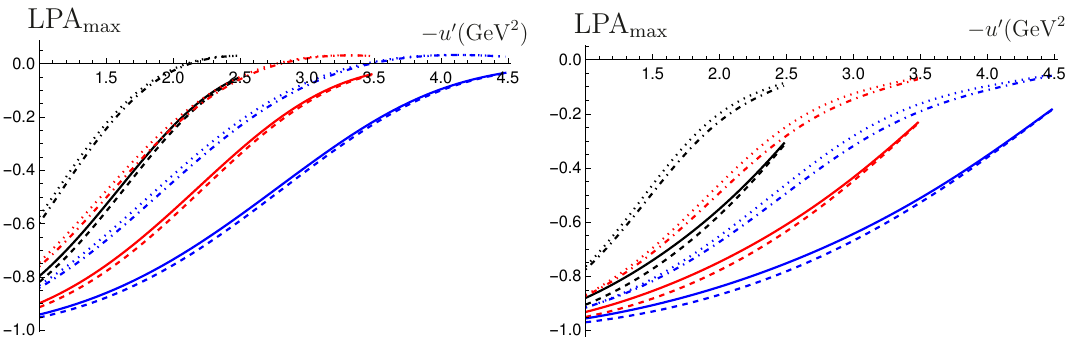
Figure 18 . The LPA at the fully-differential level for π + ( π − ) is shown as a function of ( − u 0 ) on the left (right) for different values of M 2 . The black, red and blue curves correspond to γπ = 3 , 4 , 5 GeV 2 respectively, and S = 200 GeV 2 . The dashed (non-dashed) lines correspond M 2 γN γπ to holographic (asymptotic) DA, while the dotted (non-dotted) lines correspond to the standard (valence)